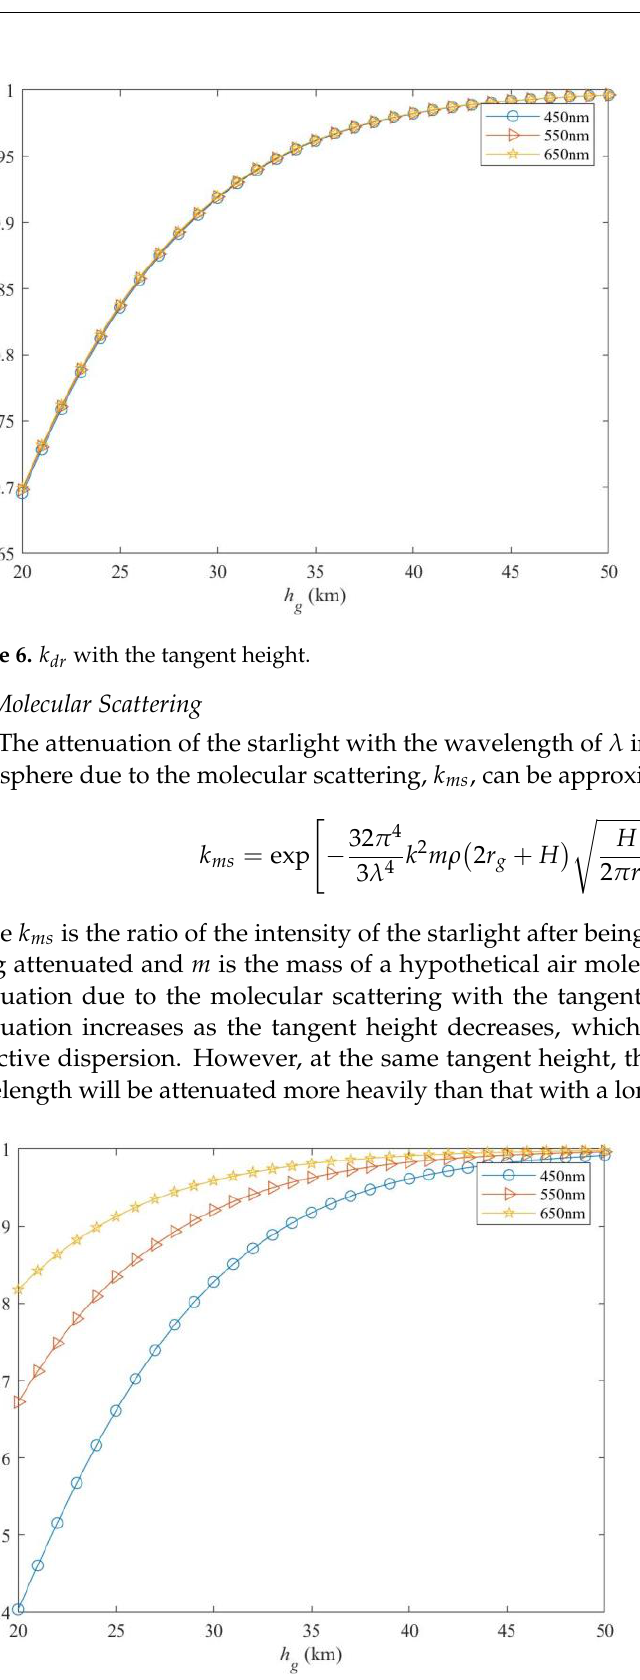
k Figure 7. k ms with the tangent Figure 7. m s with the tangent height